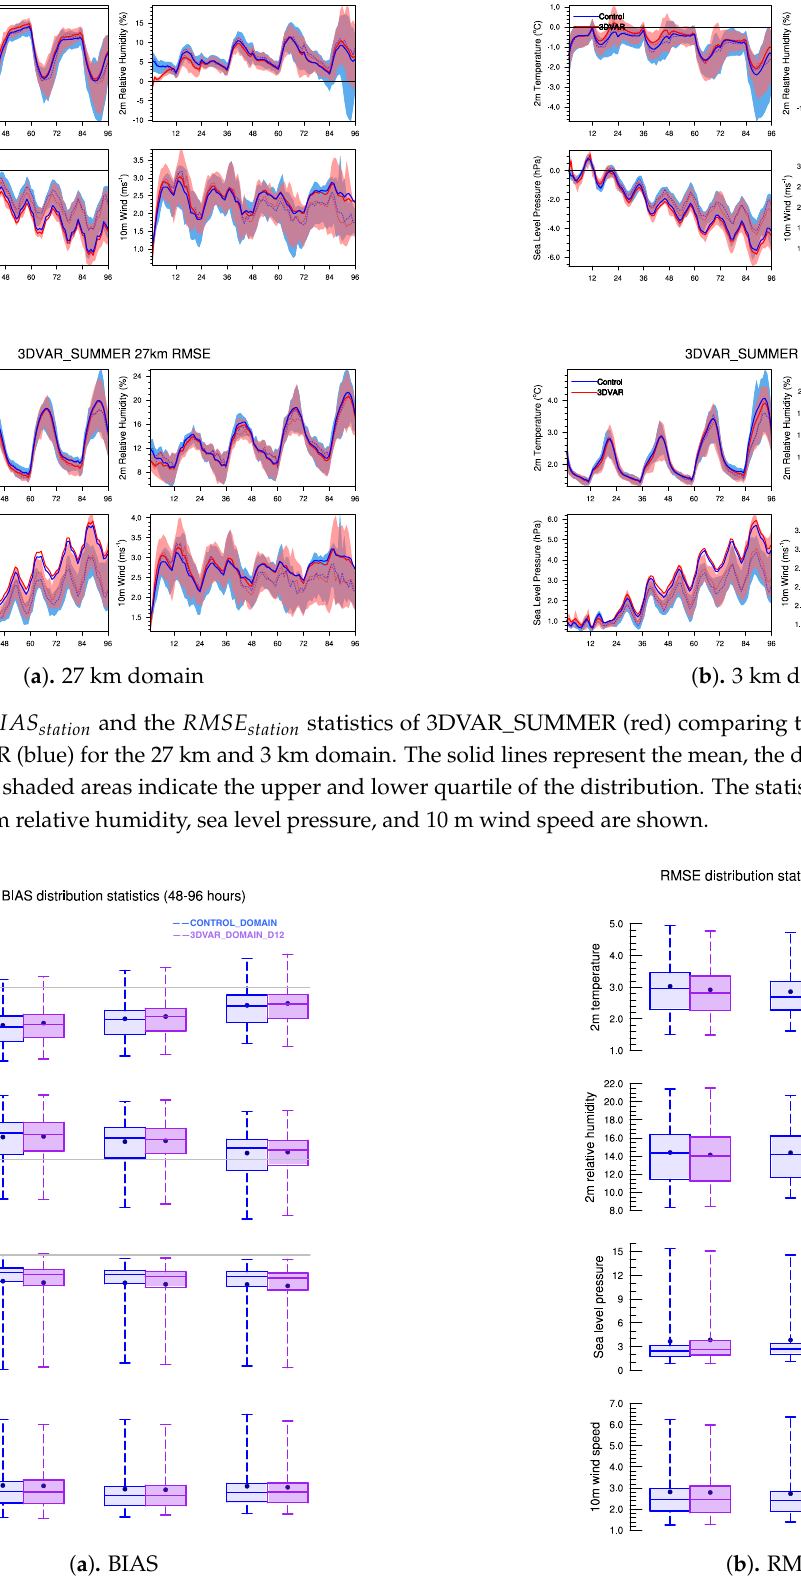
Figure 9. The distribution statistics of BIAS time and RMSE time for variables T2, RH2, SLP, and 10 m wind for all the time period sensitivity experiment cases [CONTROL_DOMAIN(left), 3DVAR_DOMAIN(right)] between the 48 and 96 h time window in the summer. The blue dots refer to the